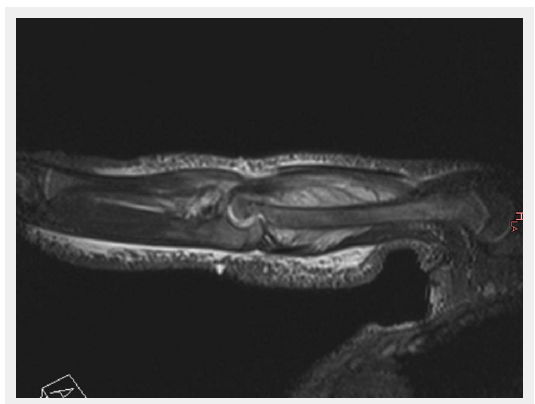
An 8-month-old boy sustained osteoarthritis of the left hip due to Streptococcus pneumoniae. Six months after the infection, the epiphyis had completely disappeared, confirming that children with osteoarticular infection due to S. pyogenes are more likely to have joint involvement, spread of infection into the epiphysis, and thus subsequent disturbed epiphysial growth.